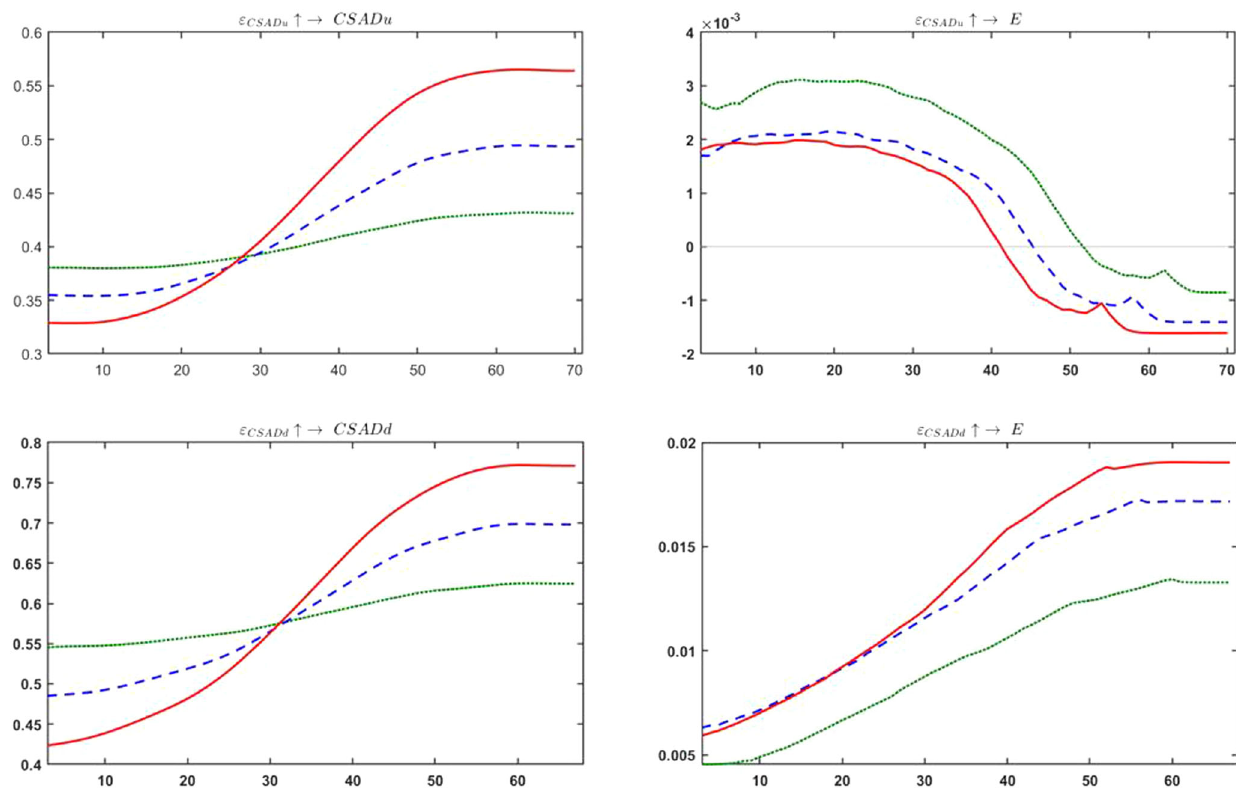
Fig. 7 Impulse responses in different ahead periods. The long-, medium- and short-term responses of market dispersion and internet postings to a unit shock of increasing dispersion or decreasing